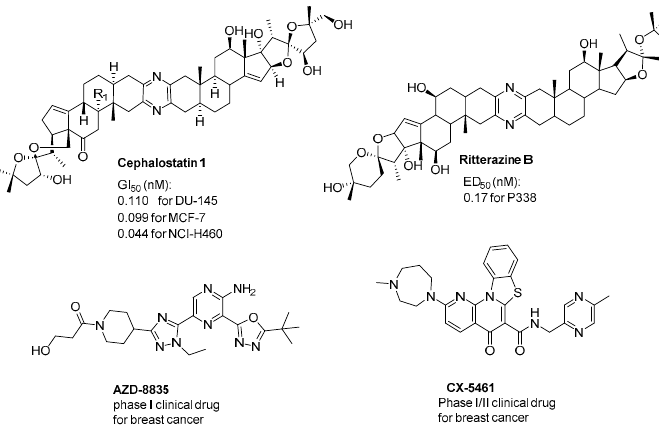
Figure 2. The structures of anticancer agents containing a pyrazine moiety.